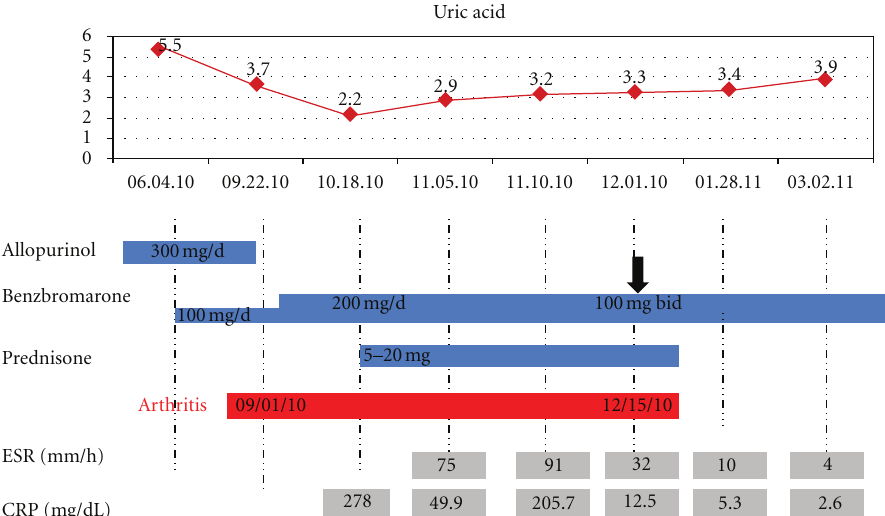
Figure 1: Graphic demonstrating reported gout patient outcomes: uric acid (red line), drugs (blue bar), laboratory tests (gray bar), and arthritis duration (red